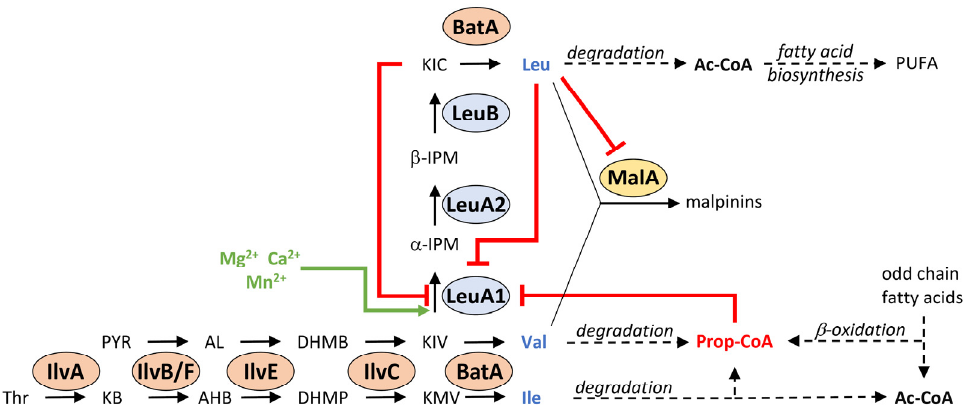
Figure 7. Schematic representation of the regulation of the BCAA and malpinin biosynthetic pathways in M. alpina. Enzymes and metabolic intermediates are listed in Figure 1. Ac-CoA, acetyl-coenzyme A; MalA, malpinin synthetase; Prop-CoA, propionyl-coenzyme A; PUFA, even-chain polyunsaturated fatty acids. Arrows and lines: continuous line, one catalytic step; dashed line, multiple catalytic steps; green bold lines, induction by metal ions; red bold lines, inhibition by intermediates or products.